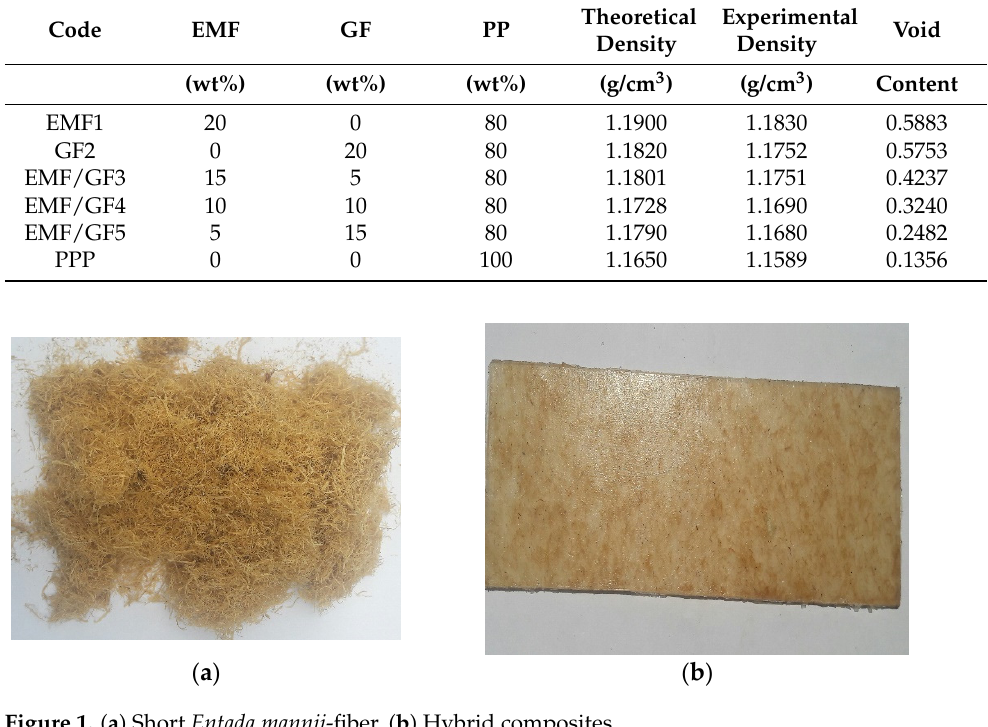
Figure 1 ( a ) Short Entada mannii -fiber, ( b ) Hybrid composites. Figure 1. ( a ) Short Entada mannii -fiber, ( b ) Hybrid